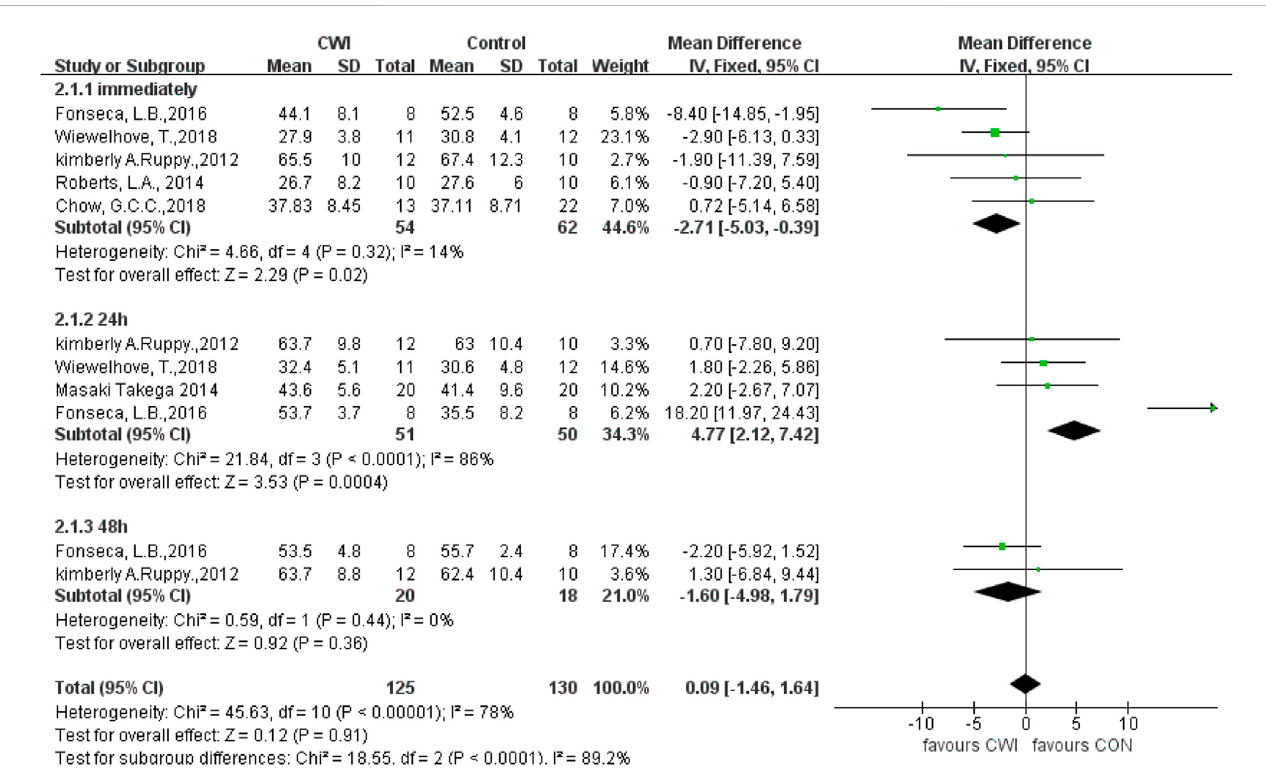
FIGURE 4 Forest plot of the comparison of CWI versus CON for measurement of CMJ. CWI = Cold water immersion, CON = Control, CMJ = countermovement jump.